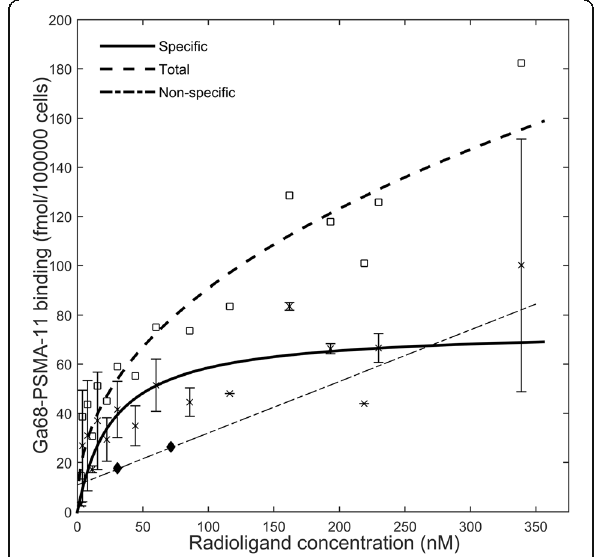
Fig. 5 Total and specific saturation binding of Ga68-PSMA-11 to hu- man LNCaP cells at equilibrium. The error bars indicate standard